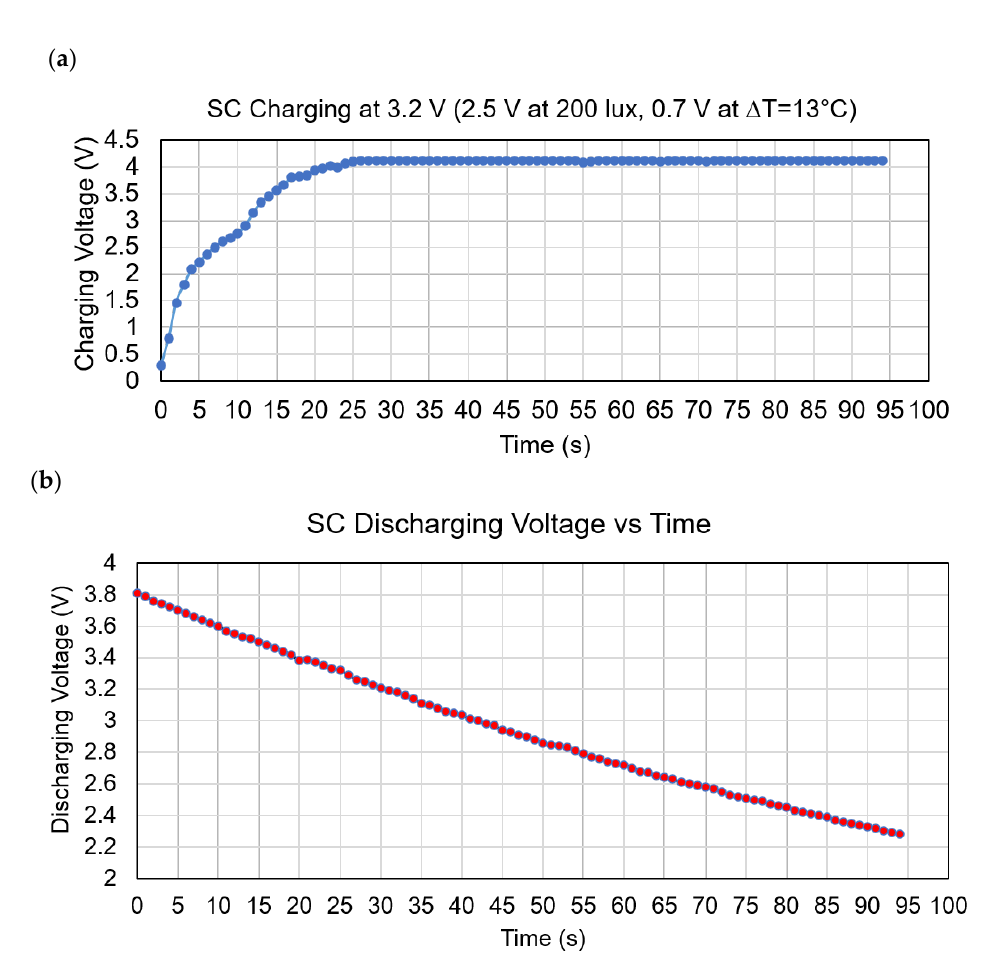
Figure 12. State of charge and discharge, ( a ) Supercapacitor charging at maximum 3.2 V input voltage; ( b ) SC discharging voltage versus time.